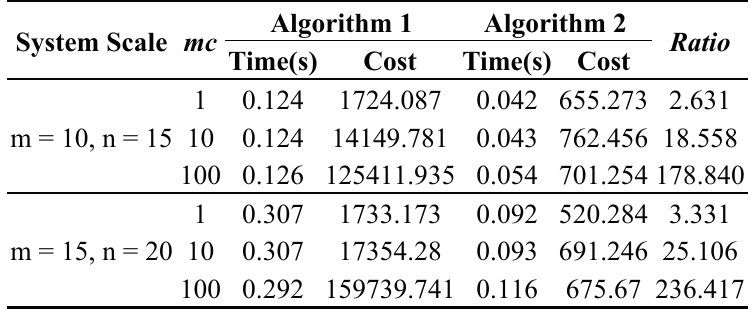
Table 4. Simulation result for the perfect test cases (N = 1000, L = 3).